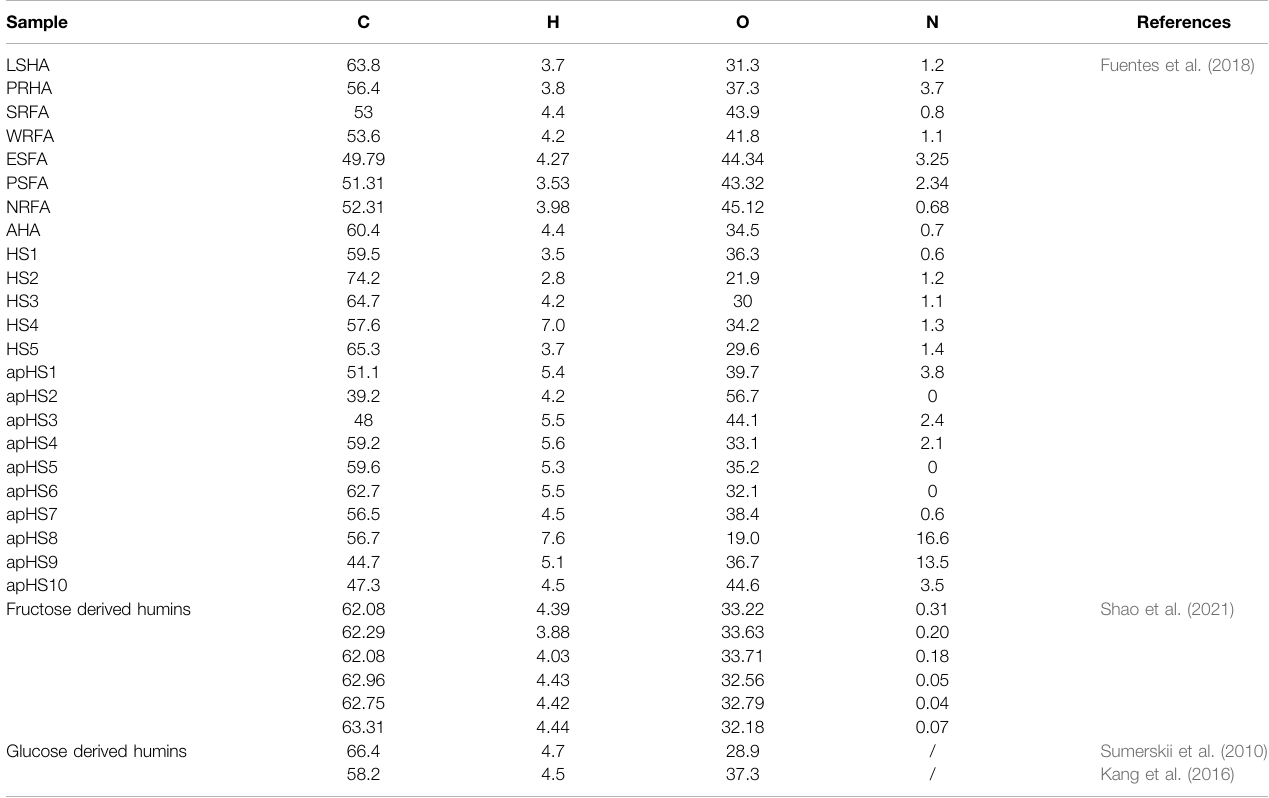
TABLE 2 | The element composition (w/w%) of the HSs.